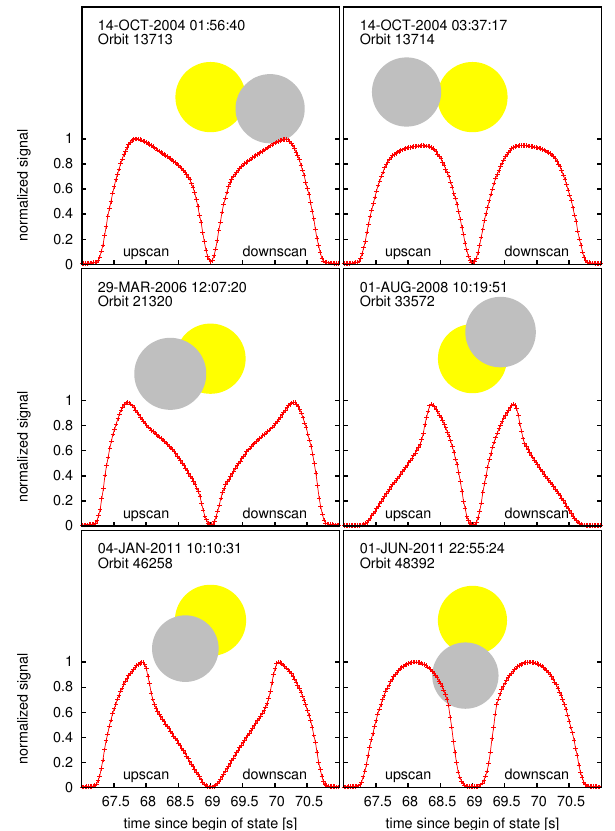
Fig. 7. Observation of solar eclipses during SCIAMACHY’s so- lar occultation measurements. Plotted is the normalized signal of PMD 4 of the first up- and down-scan above 100km of the affected orbit. The first two plots are subsequent orbits, observing begin and end of the solar eclipse of 14 October 2004. The coverage of the Sun by the Moon is pictured by the yellow and gray circle. The di- ameters of Sun and Moon and the relative elevation and azimuth angles are consistently scaled.